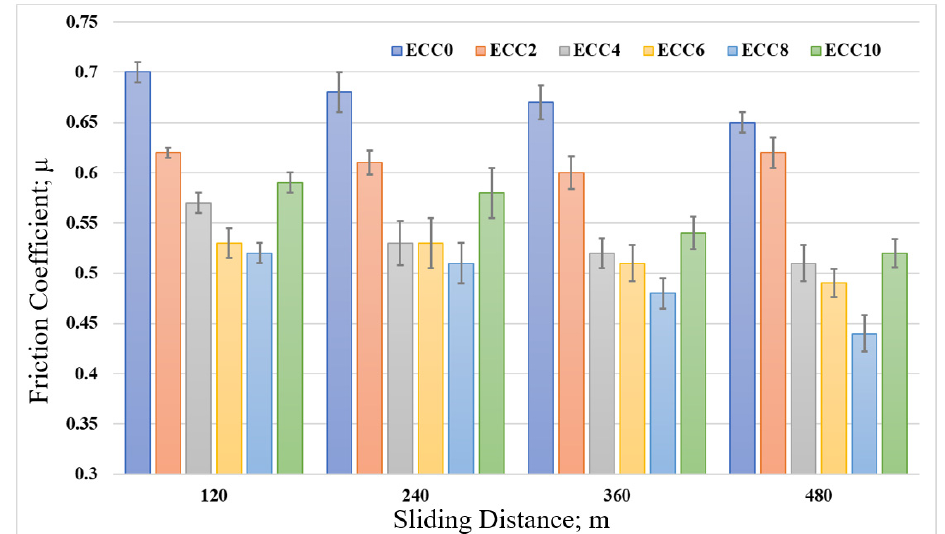
9 of 16 Figure 7. The friction coefficient of epoxy/corn cob composites under different normal loads. Figure 8 shows the influence of the sliding distance on the friction coefficient of epoxy/corn cob composites. The sliding distances were varied from 120 m to 480 m under a normal load of 12 N. Generally, the friction coefficient decreased with the increase in the sliding distance, while 8 wt% corn cob still recorded the lowest coefficient of friction among other composites. The decrease in the friction coefficient could be attributed to the smoothness in the epoxy composite surface after rubbing for a long distance against the stainless steel disk. Furthermore, Dass et al. [10] reported that after rubbing polymeric samples for a long time, the generated heat could melt the surface of the composite. Con- sequently, a thin film of the melted polymer composite is transmitted to the counterpart. It works as a lubrication layer between the rubbed surfaces, resulting in a decrease in the